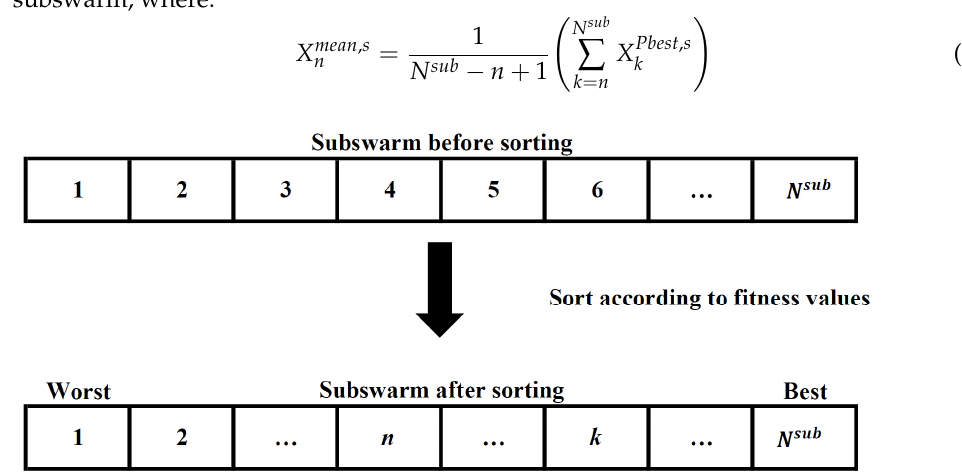
Figure 2. Graphical illustration of sorting all particles stored in each subswarm based on their personal best fitness values.